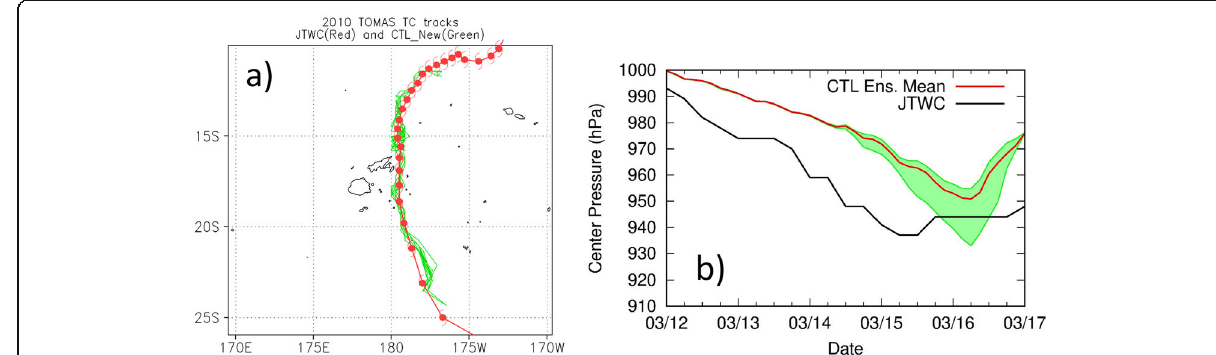
Fig. 5 Tracks and center pressures of TC Tomas. a Tracks of TC Tomas. The red line represents the best track by JTWC. The green lines represent the results of the ensemble simulation. b Temporal variations in the center pressure of TC Tomas. The black line represents the result of the best track by JTWC. The red line indicates the ensemble mean center pressure. The range of the ensemble spread is represented by green shading